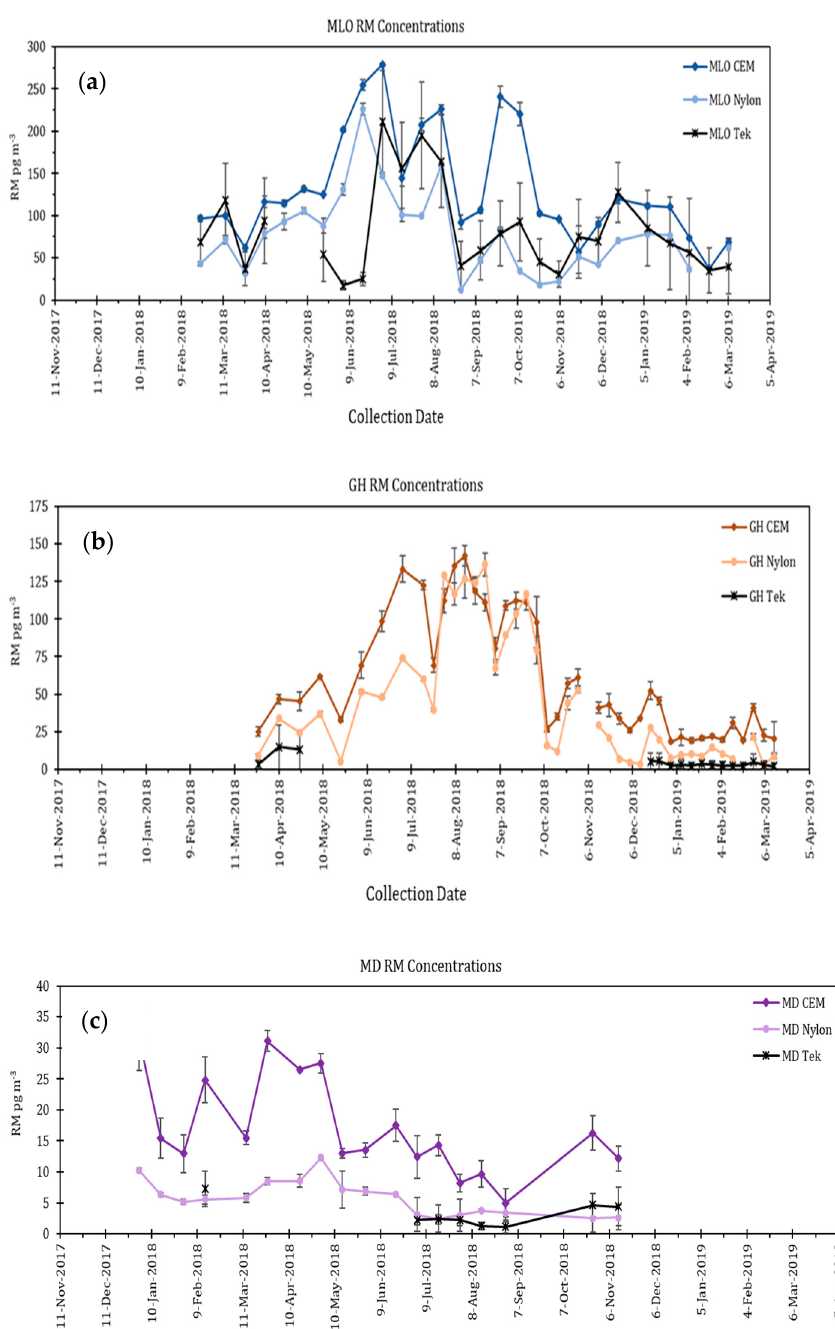
Figure 3. RM concentration data collected using Tekran system and RMAS 2.0 membranes (CEM and nylon) from November 2017 to March 2019 at 4 locations: Moana Loa, (MLO) Hawaii; Reno, NV (GH); and Piney Reservoir in Maryland (MD). ( a ) MLO; ( b ) GH ( c ) MD. Modified from Luippold et al. [48]. Each panel shows CEM and nylon membrane RM concentrations as compared to Tekran RM data for MD and HI, and GOM data only for the Tekran deployed in